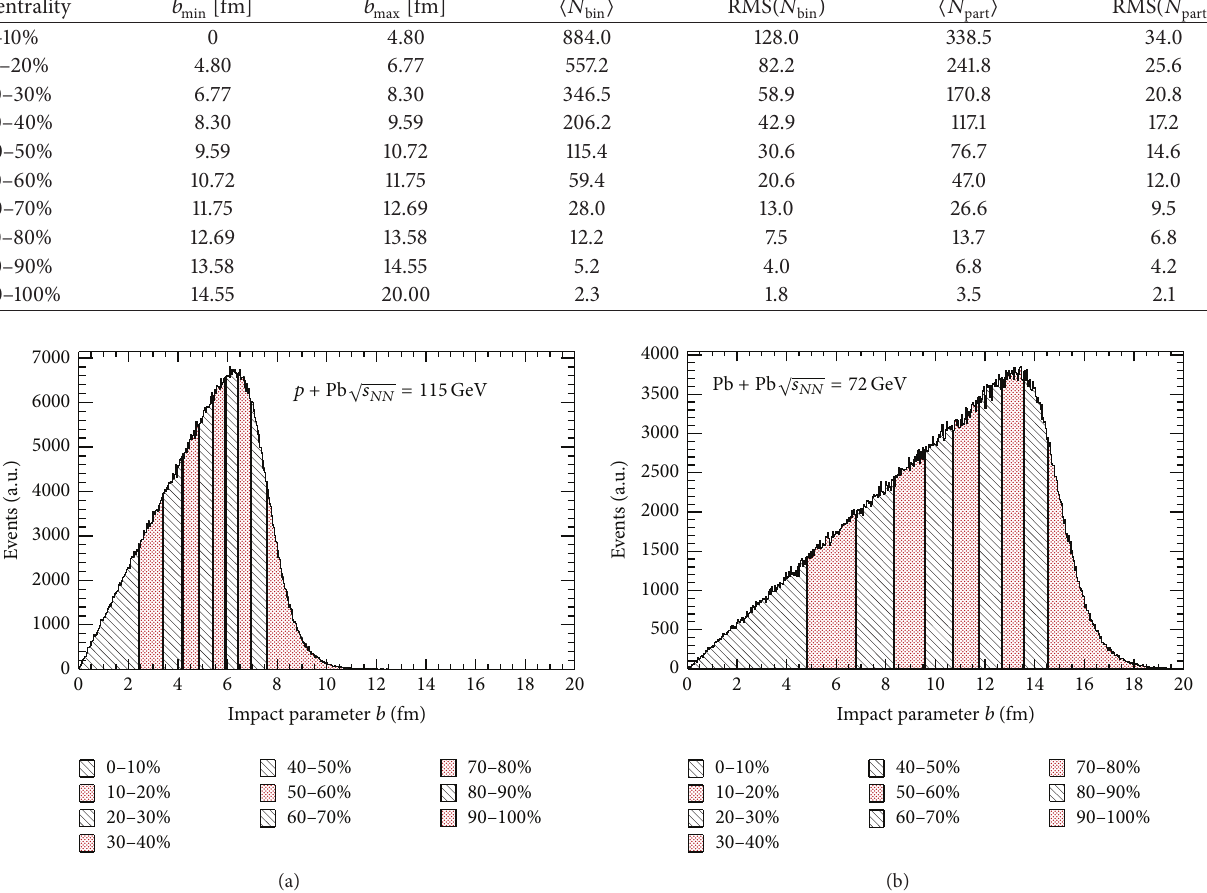
Figure 1: Impact parameter distribution for percentiles of the hadronic cross section obtained from a Glauber Monte Carlo calculation in (a) = 115 GeV and (b) Pb-Pb collisions at √𝑠 𝑝 -Pb collisions at √𝑠 𝑁𝑁